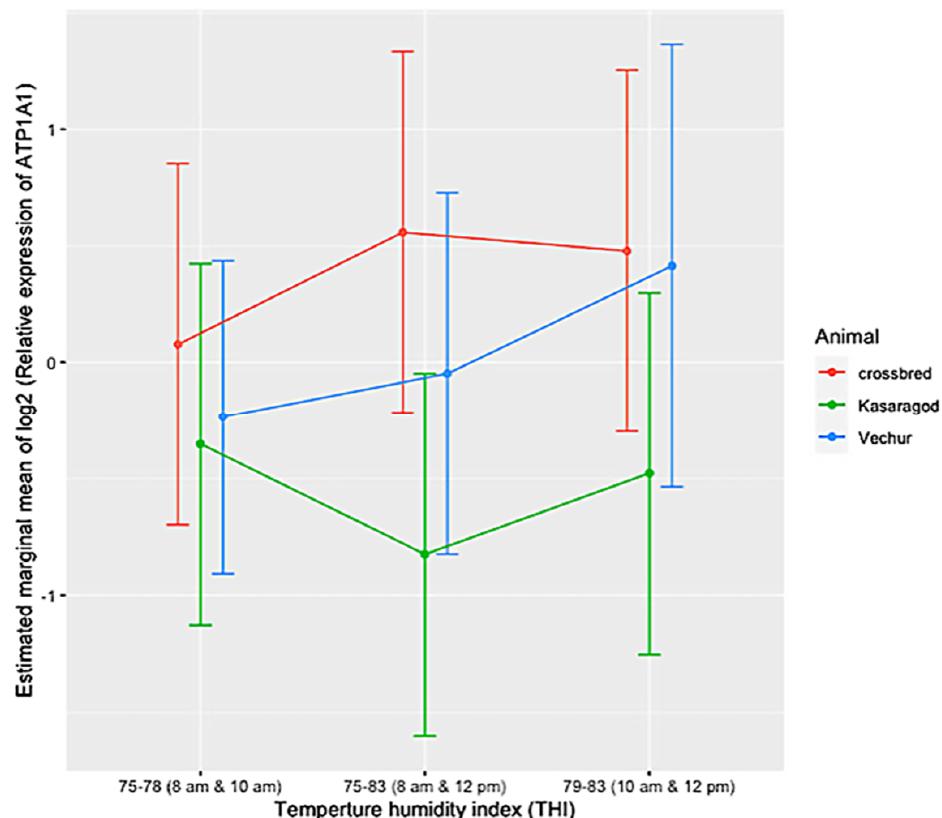
Figure 3. Relative expression of the ATP1A1 gene in Vechur, Kasaragod, and crossbred cattle during different periods from 08:00 h to 12:00 h. Period 1 was between 08:00 and 10:00; period 2 was between 10:00 and 12:00; period 3 was between 08:00 and 12:00. The estimated marginal mean is shown on the y axis. The expression profile of ATP1A1 varied significantly among the breeds (p = 0.02). However, the effects of time and the time x breed interaction were not significant. Pair-wise comparison of ATP1A1 expression levels in different lineages showed significant difference in expression between Kasargode and crossbred cattle ( p =